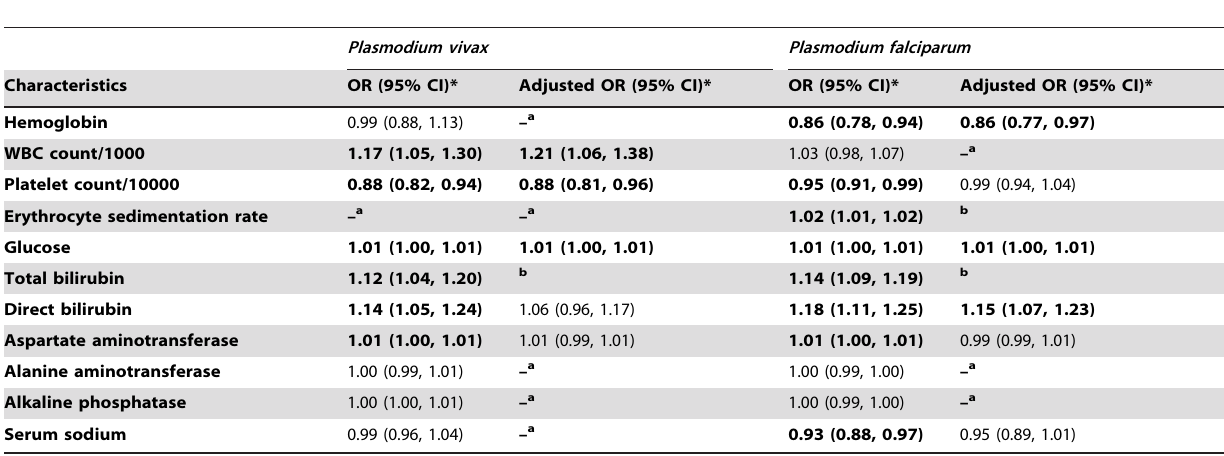
Table 8. Univariate and Multivariate Analysis for Laboratory Factors Associated with AKI by Malaria Species.